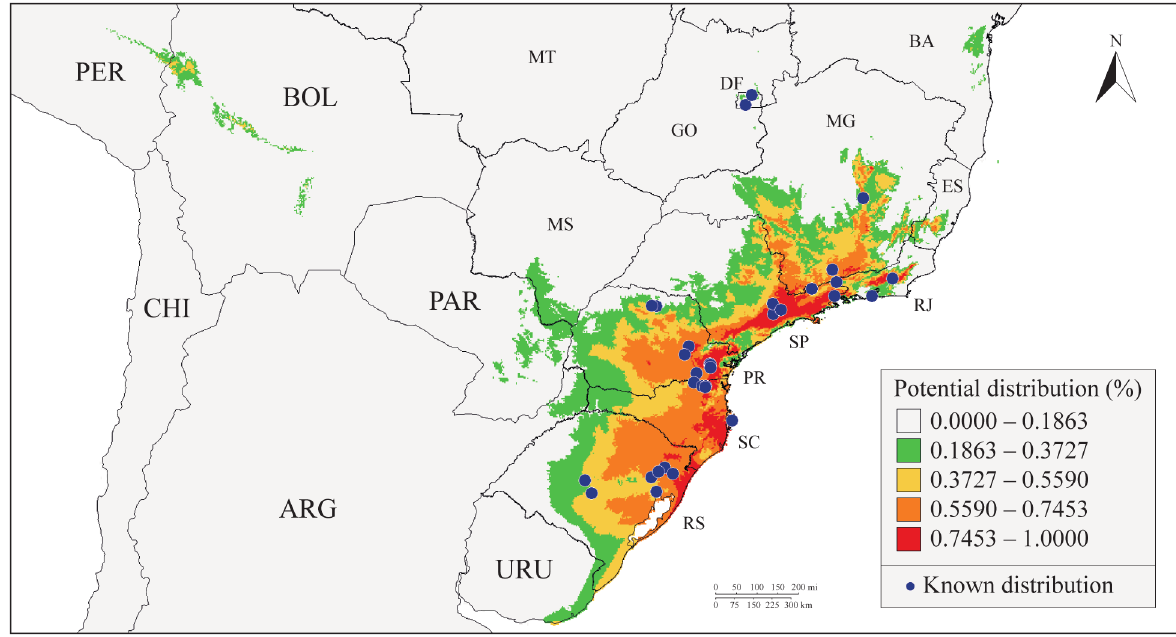
Figure 3. Potential and known distribution of Psyllotoxus griseocinctus in South America. Abbreviations: ARG, Argentina; BOL, Bolivia; CHI, Chile; PAR, Paraguay; PER, Peru; URU, Uruguay. Brazilian federative units: BA, Bahia; DF, Federal District; ES, Espírito Santo; GO, Goiás; MG, Minas Gerais; MS, Mato Grosso do Sul; MT, Mato Grosso; PR, Paraná; RJ, Rio de Janeiro; RS, Rio Grande do Sul; SC, Santa Catarina; SP, São